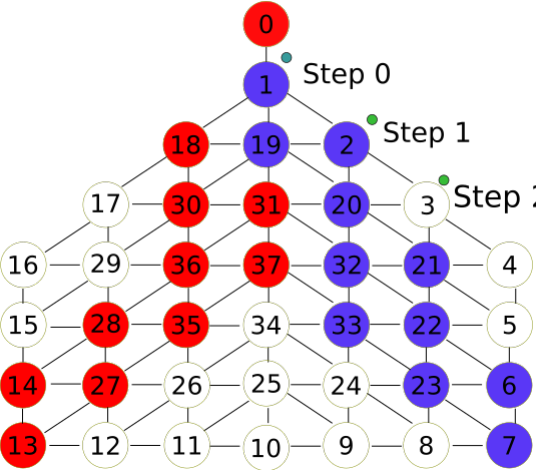
Figure A1. Two MDFs do the recoinnasance task. Each pheromone deposited by the MDFs is colored as red or blue.